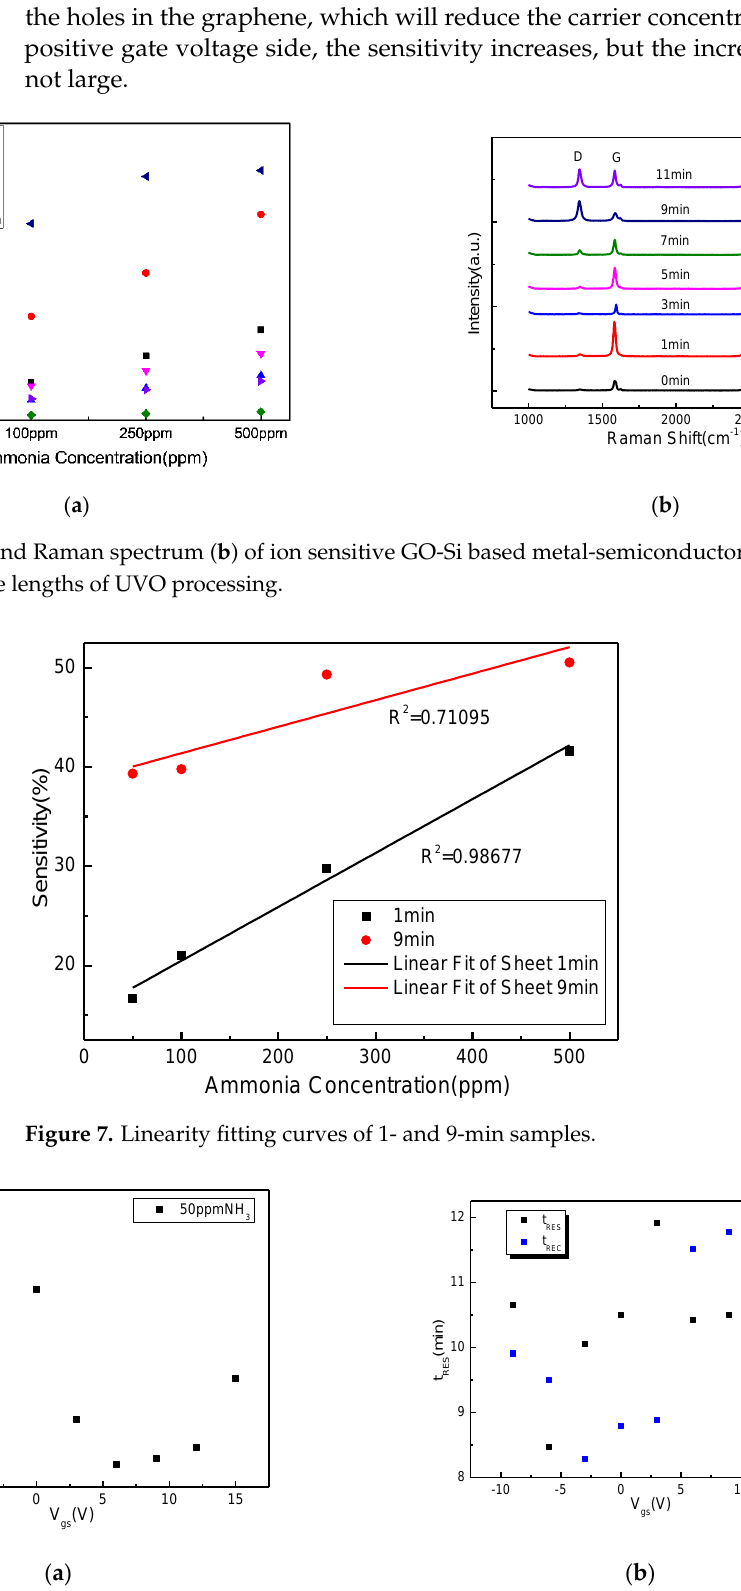
Figure 7. Linearity fitting curves of 1- and 9-min samples. Figure 8. Sensitivity ( a ) and time response ( b ) curve of UVO 1-min sample with the concentration of 50 ppm ammonia at different gate pressures.